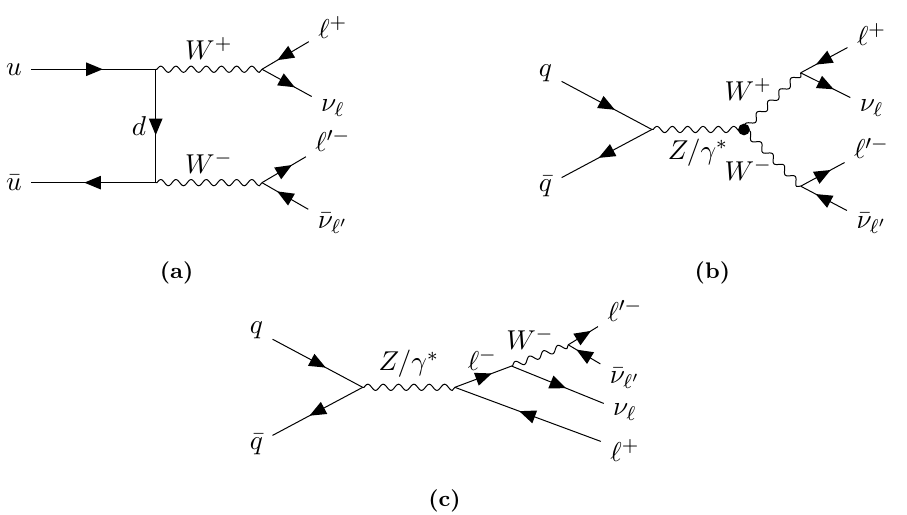
Figure 1. Sample LO diagrams in the different-flavour channel ‘ + (cid:23) ‘ ‘ 0(cid:0) (cid:22) (cid:23) ‘ 0 for (a) t -channel W + W (cid:0) production, (b) s -channel Z=(cid:13) ? ! W + W (cid:0) production, and (c) DY-type production.